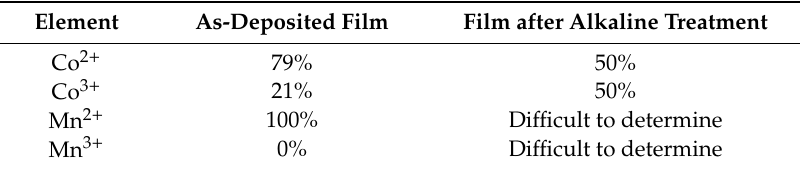
Table 1. The percentage content of certain elements in the as-deposited Mn-Co film and the film after alkaline treatment determined based on the XPS (surface concentration, error ≤